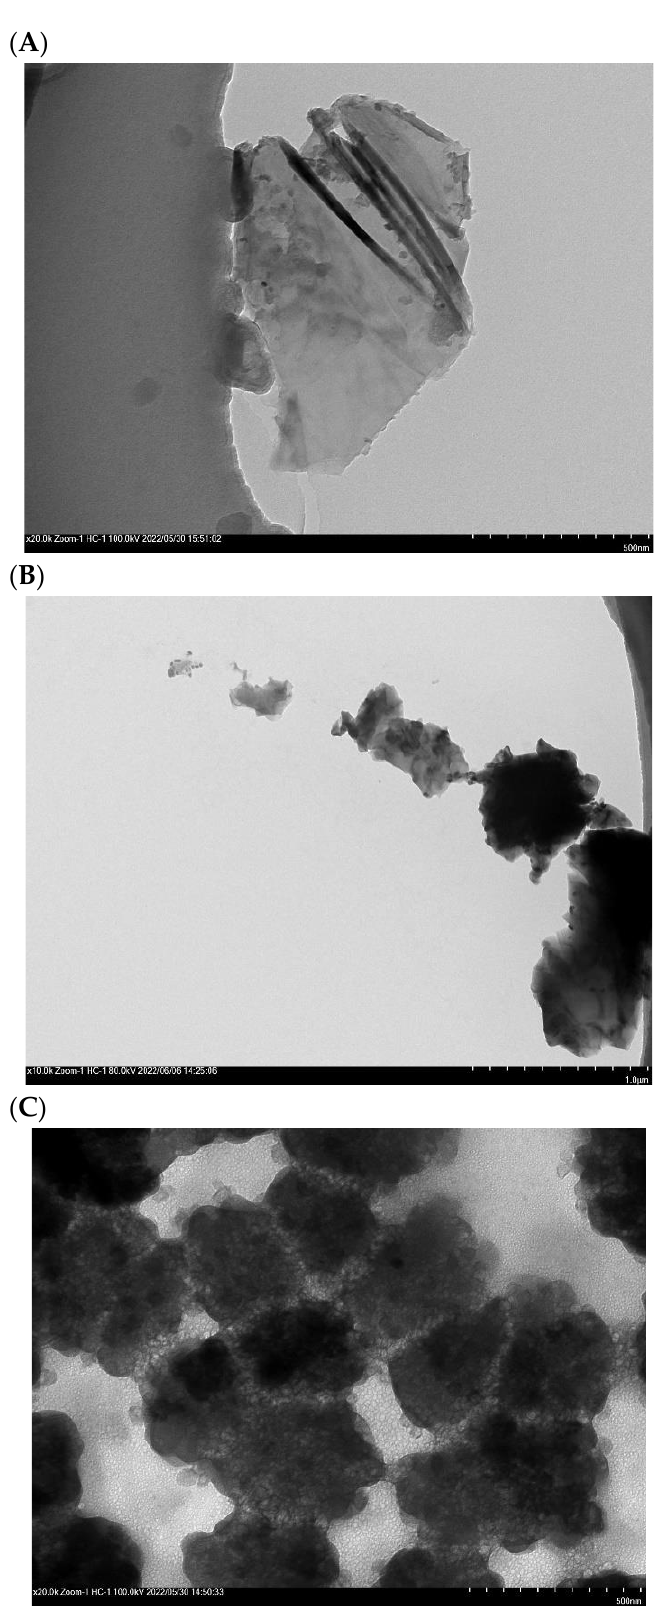
Figure 16. The representative TEM images. ( A ) SpyCatcher-CpCR. ( B ) SpyTag-GDH. ( C ) 10 k× CpCR-SpyCatcher-SpyTag-GDH.